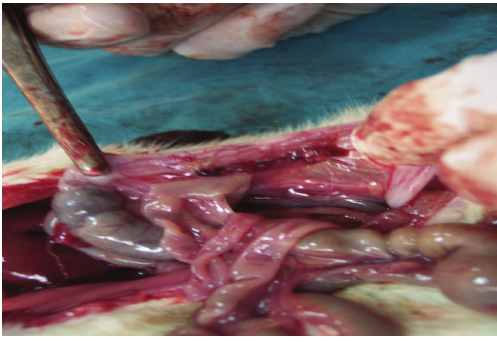
Figure 1: Devascularization